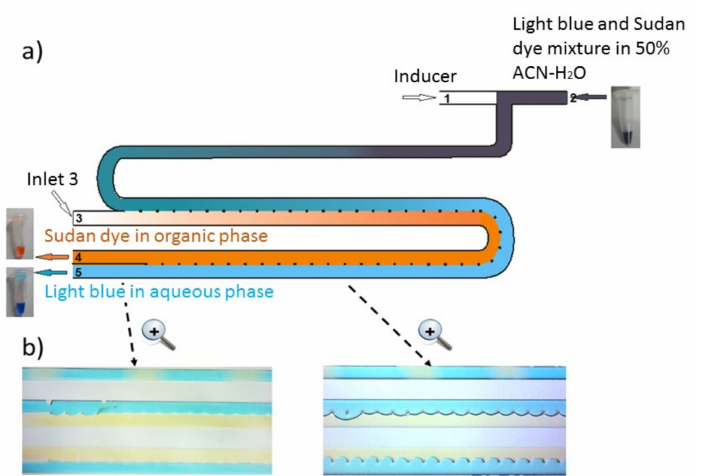
Figure 1. Schematic representation of the induced phase separation extraction chip: ( a ) lay-out of the IPSE chip when filled with a dye mixture (Indigo blue and Sudan red); ( b ) photos of parts of the IPSE chip while separating a blue-orange dye mixture by using the mixed inducer (dichloromethane–butyl acetate